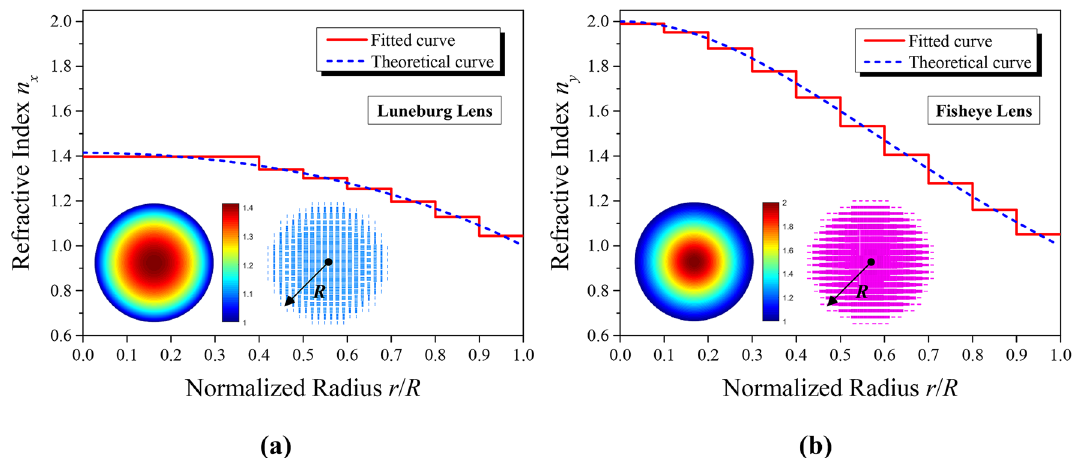
Figure 6. Comparison of the refractive index profiles between the theoretical and fitting distribution. In each graph, the left inset describes the ideal distribution of refractive index, and the right one exhibits the practical schematic of the synthesized lens. ( a ) Mapping of the Luneburg lens (top view). ( b ) Mapping of the Maxwell fisheye lens (bottom view).